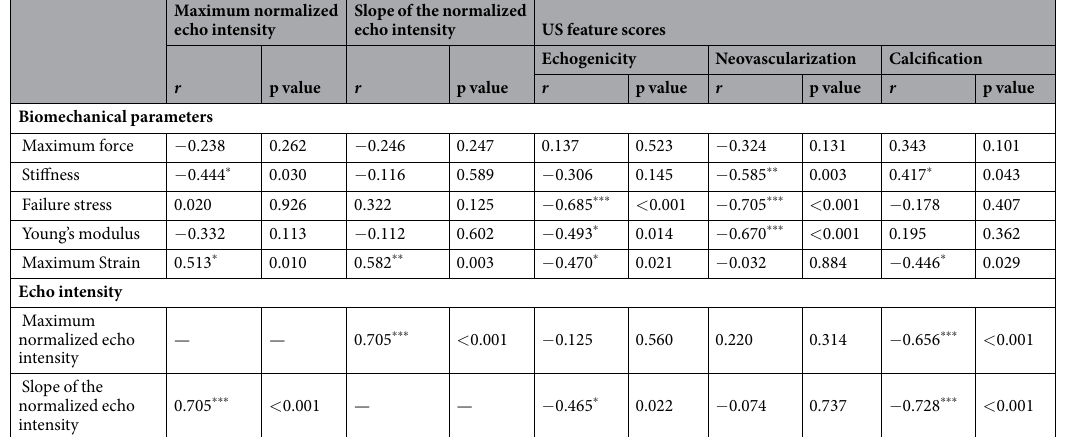
Maximum normalized Slope of the normalized echo intensity echo intensity US feature scores Echogenicity Neovascularization Calcification r p value r p value